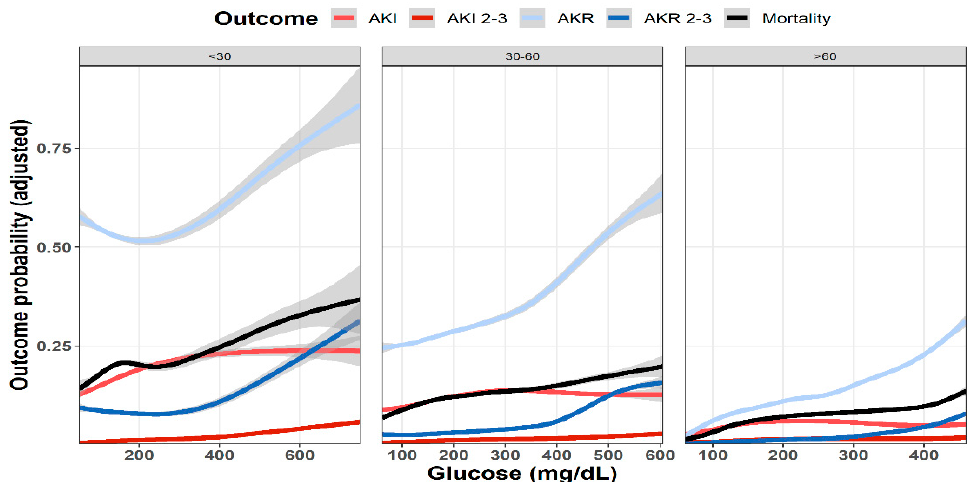
Figure 2. Predicted probability of various outcomes (AKI, AKR, and mortality at 30 days) as a function of baseline glucose levels in diabetic and non-diabetic patients. Lowest and highest 0.5% percentile of patients by glucose levels of each analyzed group were excluded. Data were plotted using cubic splines.